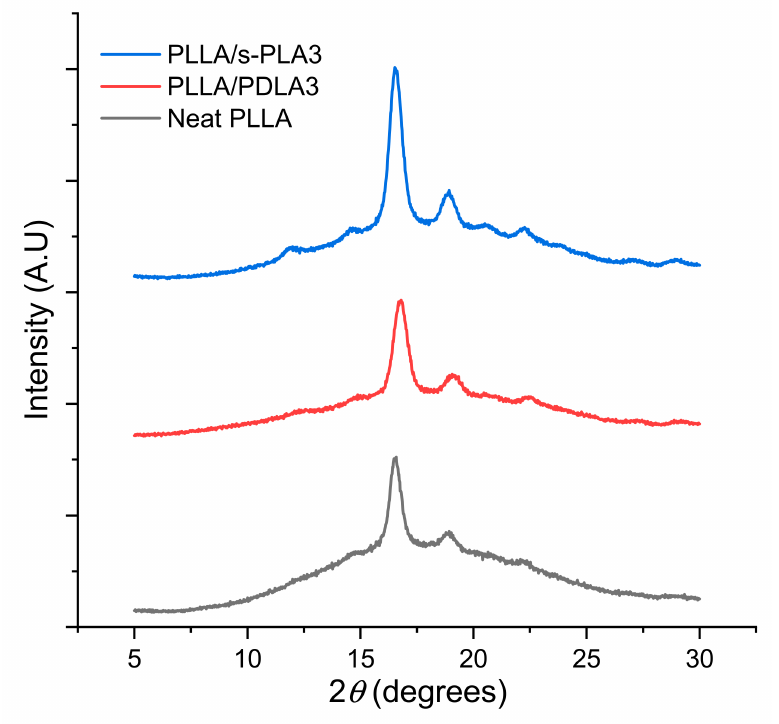
Figure 2. X-ray diffraction pattern of PLLA homopolymer, PLLA/PDLA3 and PLLA/s-PLA